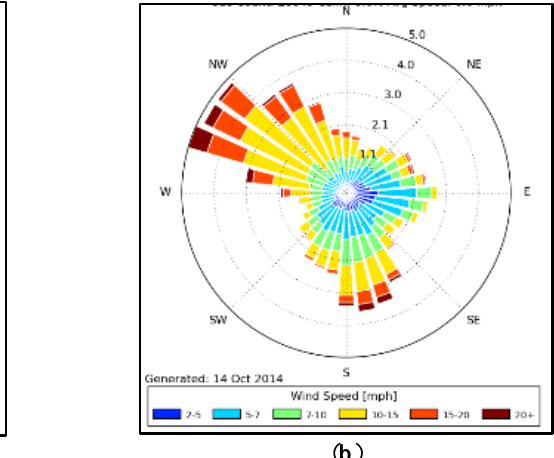
Figure 2. Two cases, old and new. ( a ) — Traditional Al Marijah, heart of Sharjah heritage area [42]. ( b ) — Sharjah, in the United Arab Emirates [42,43]. ( c ) — The modern Sharqan area [42]. The UAE receives very little rain fall and has a hot, arid climate with an air tempera- ture ranging between an average maximum of around 41 °C in August and an average ranging between an average maximum of around 41 ◦ C in August and an average minimum minimum of 24 °C in January (Figure 3a). The wind is predominantly from the northwest (Figure 3b).